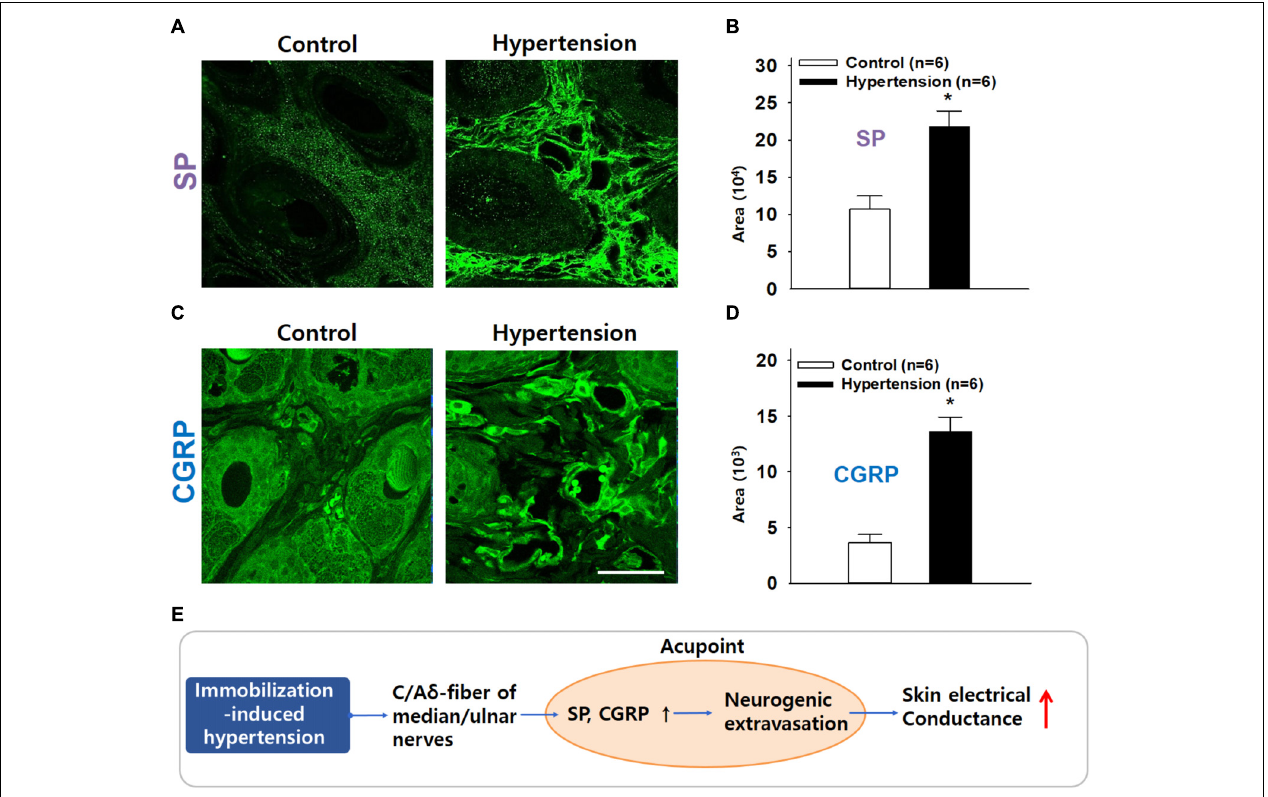
FIGURE 6 | Increased immunofluorescence of SP or CGRP in the skin over acupoints. (A,B) Greater SP expression in the wrist acupoint in IMH rats than in control rats. (C,D) Greater CGRP expression in the wrist acupoint in IMH rats than in control rats. ∗ p < 0.001 vs. control. Bar = 50 µ m. (E) Overall hypothesis. A pathological condition of hypertension antidromically activates peripheral nerves, especially small diameter sensory afferents, which causes SP and CGRP release in the acupoints containing the activated sensory afferents and thus induces vasodilation and plasma extravasation. It leads to the development of high conductance at